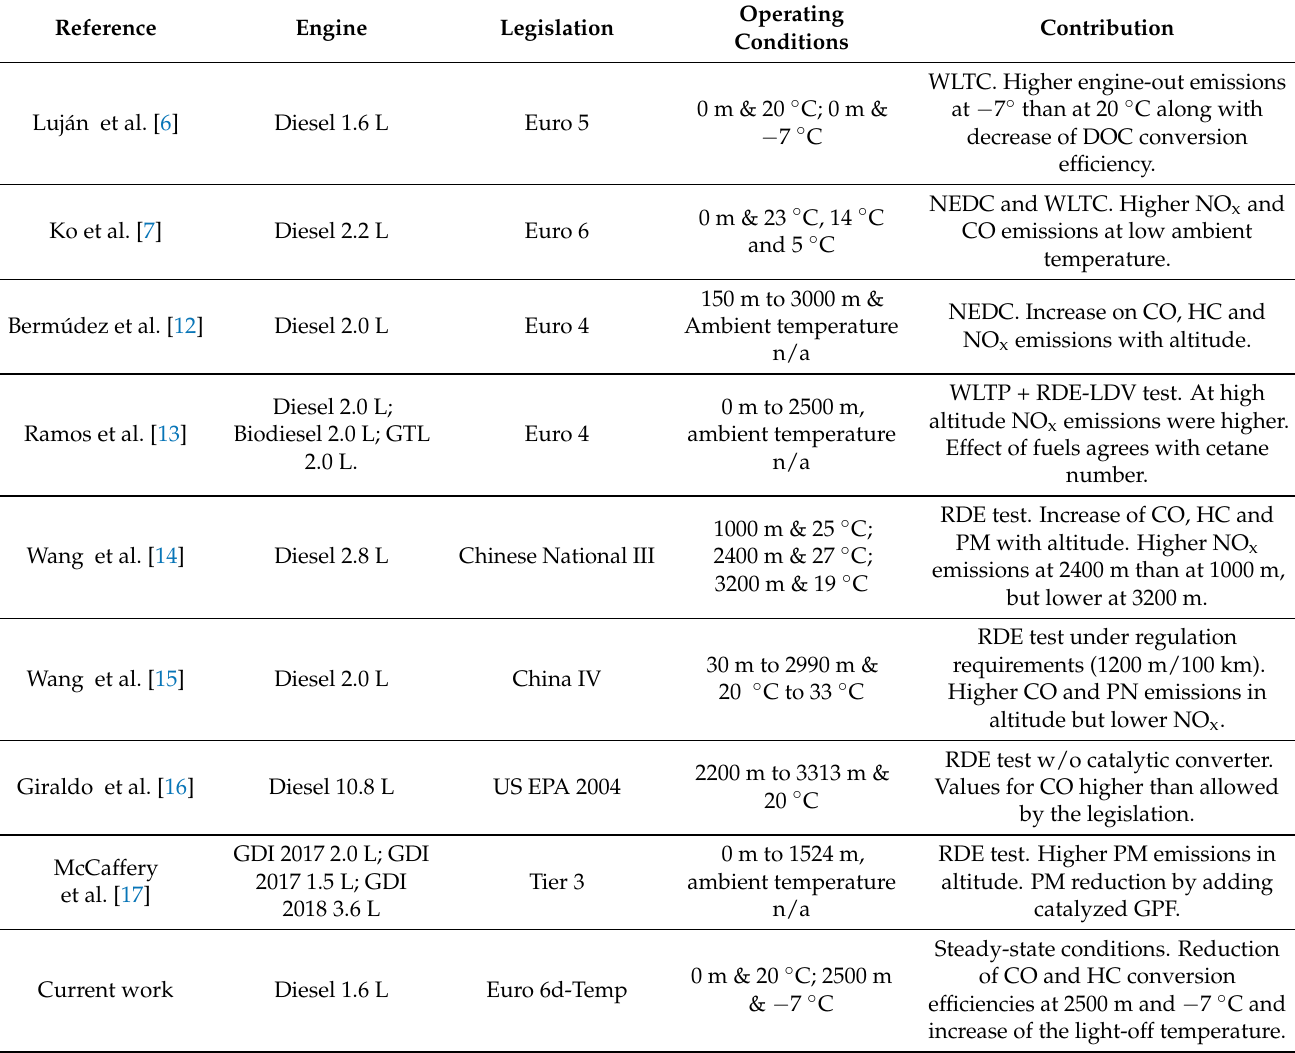
Table 1. Comparison of results reported in the literature regarding the impact of altitude and ambient temperature on emissions.